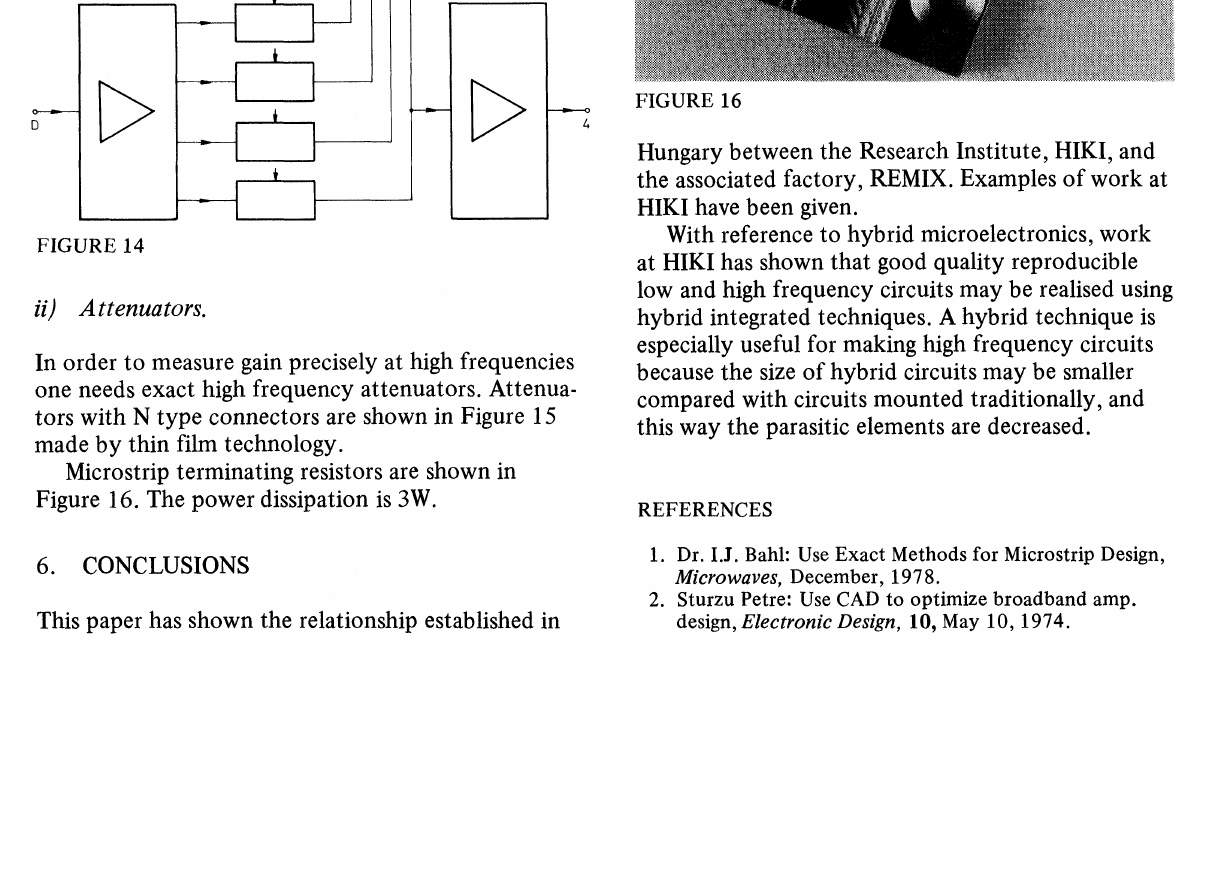
Hungary between the Research Institute, HIKI, and the associated factory, REMIX. Examples of work at HIKI have been